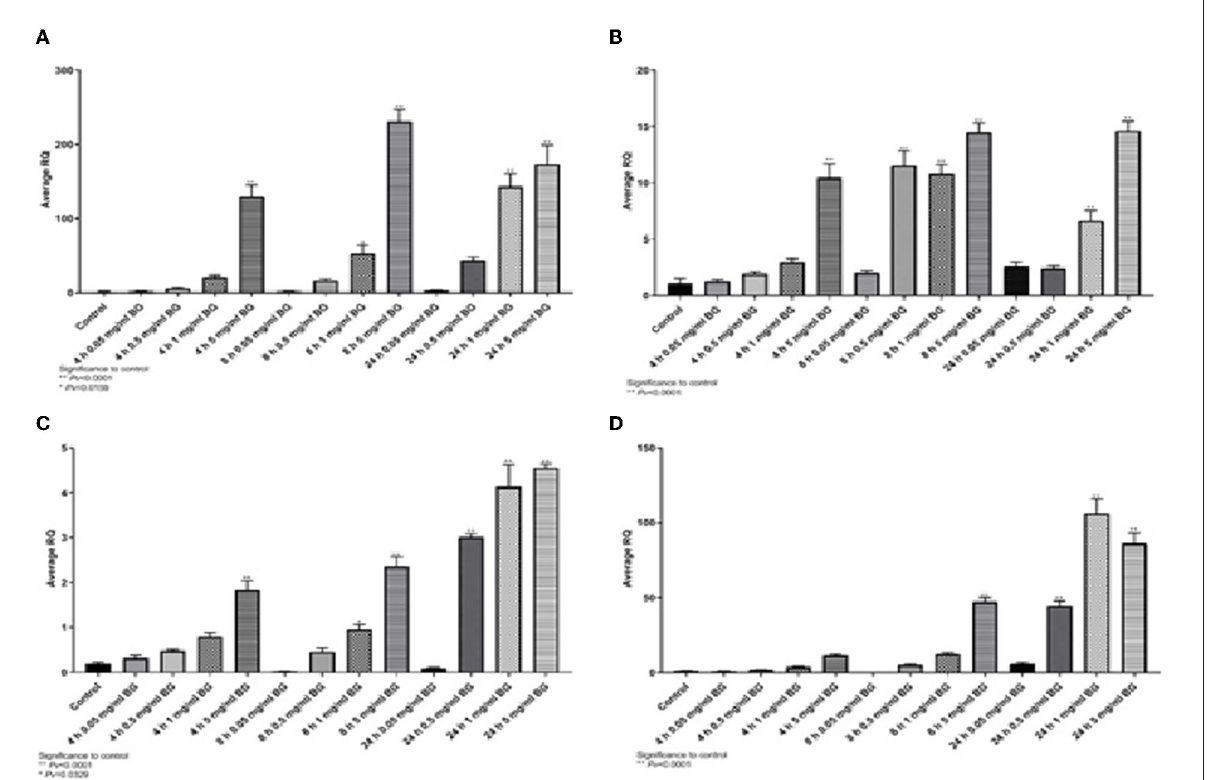
FIGURE2 Expression of cytokine genes at different algae β -glucan concentrations and incubation times. (A) IL6, (B) IL10, (C) IL8 and (D) iNOS 2